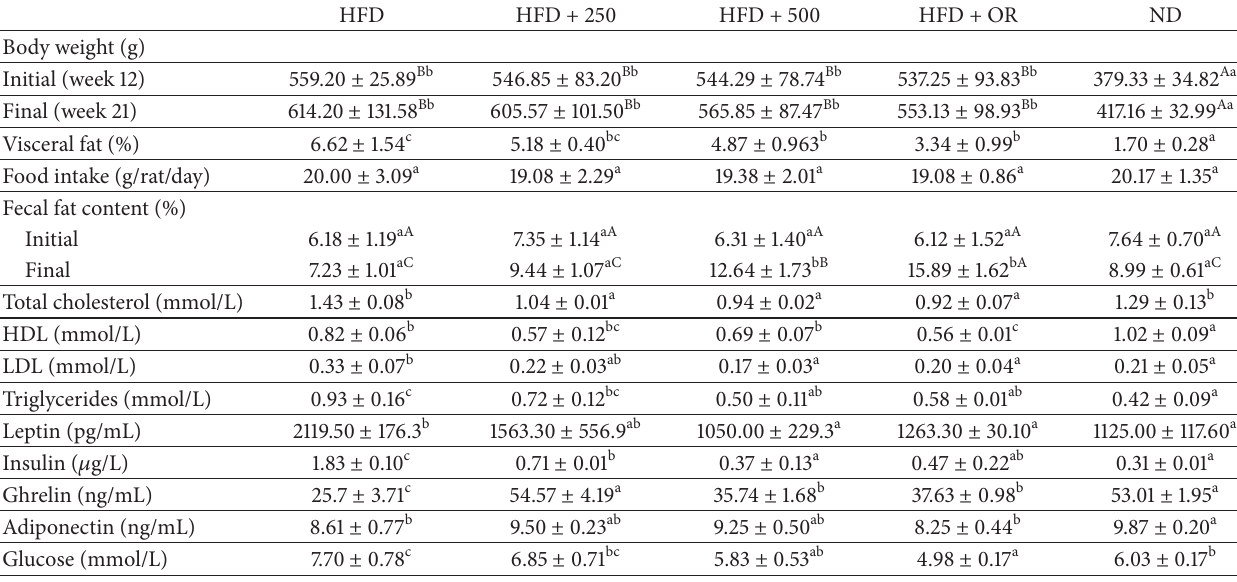
Table 4: The body weight, % visceral fat, food intake, % fecal fat excretion, and plasma biochemistry of HFD induced obese rats after 9 weeks of treatment with MLE 60 at 250 mg/kg and 500 mg/kg body and 30 mg Orlistat/kg body weight. HFD HFD +